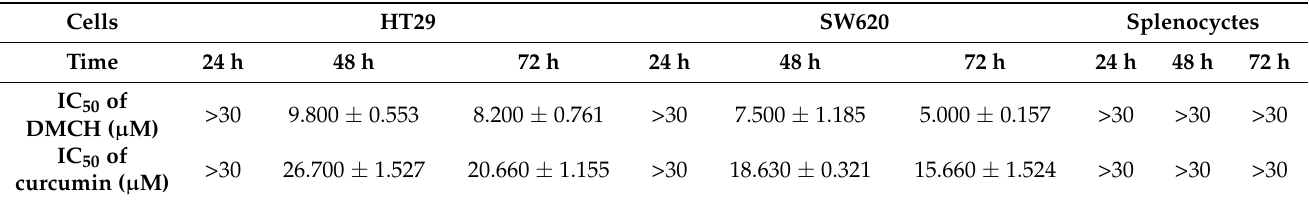
Table 1. The inhibitory concentration (IC 50 ) value of DMCH on colon cancer cell lines (SW620 and HT29) after 24, 48, and 72 h of treatment. Cytotoxicity effects of DMCH on colon cancer cell